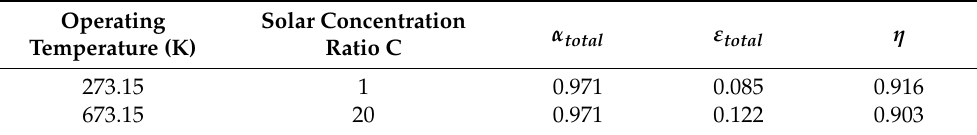
Table 1. The total solar radiation absorptivity, total thermal emissivity and solar thermal conversion efficiency for the proposed absorber at different operating conditions.